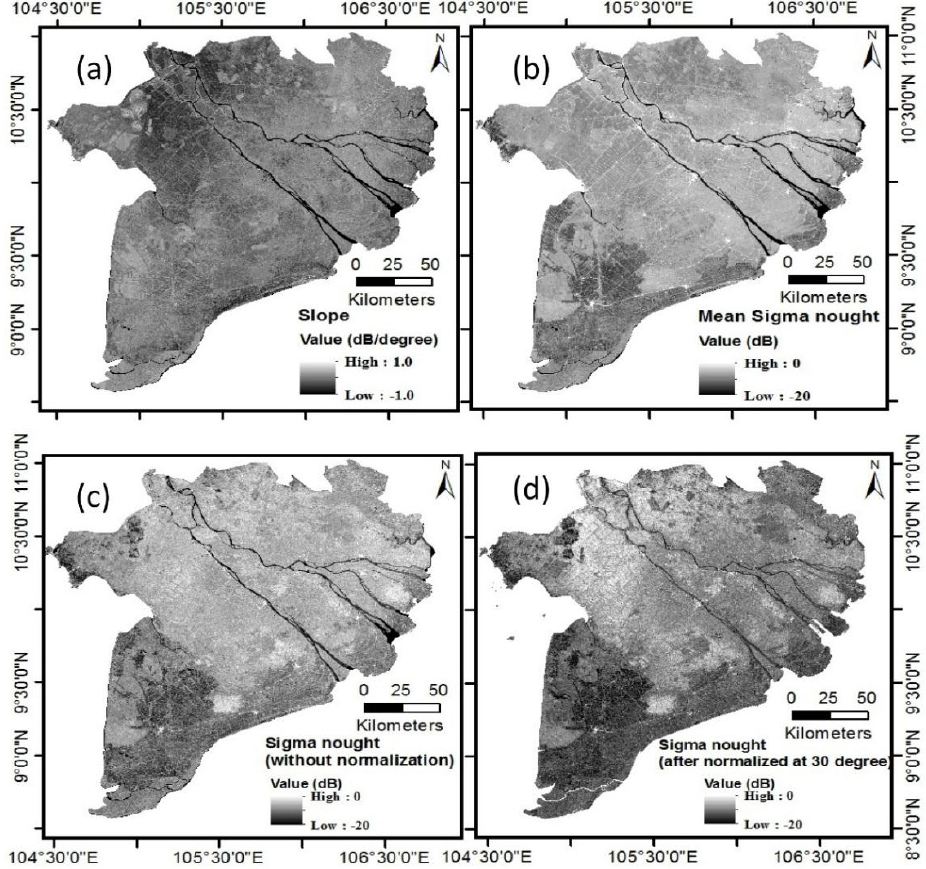
Figure 5. Slope parameter ( a ), mean backscatter without normalization ( b ), original backscatter without normalization ( c ) and backscatter normalized to 30° incidence angle ( d ) for the Envisat ASAR WSM scene from 1 March 2007.